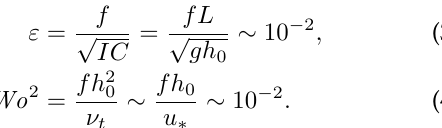
is determined to be ν t /h 2 with the eddy viscosity ν t 0 and the water depth h 0 . The order of magnitude of the eddy viscosity ν t is given by the product of frictional (cid:112) τ b /ϱ and water depth, ν t = κ u ∗ y ∼ velocity u ∗ = u ∗ h 0 . Here, κ = 0 . 4 is the von K´arm´an constant. From von K´arm´an’s